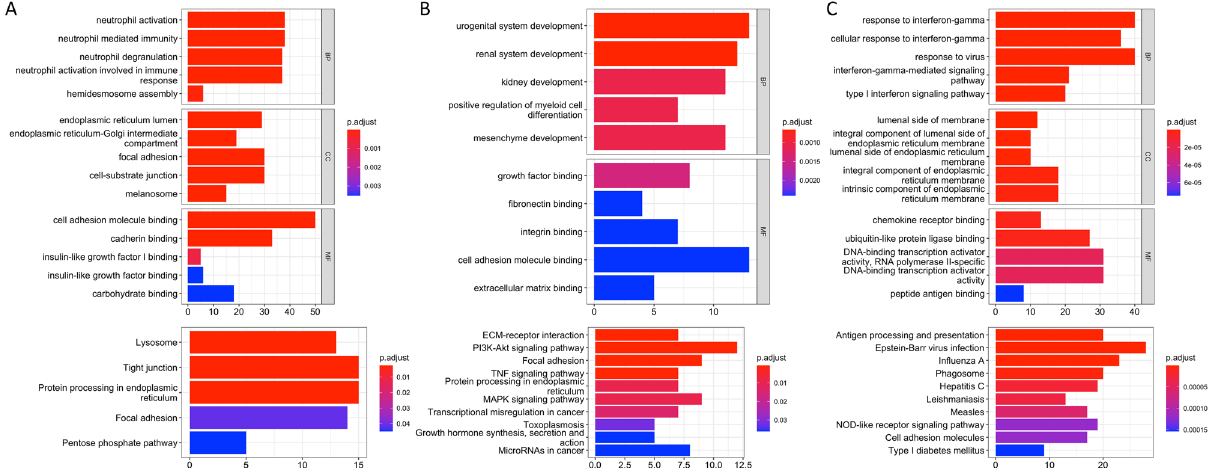
Figure 3. Kyoto Encyclopedia of Genes and Genomes and Gene Ontology enrichment analysis of Cluster-4 ( A ), Cluster-5 ( B ), and Cluster-6 ( C ). BP biological process, CC cellular components, MF molecular functions.